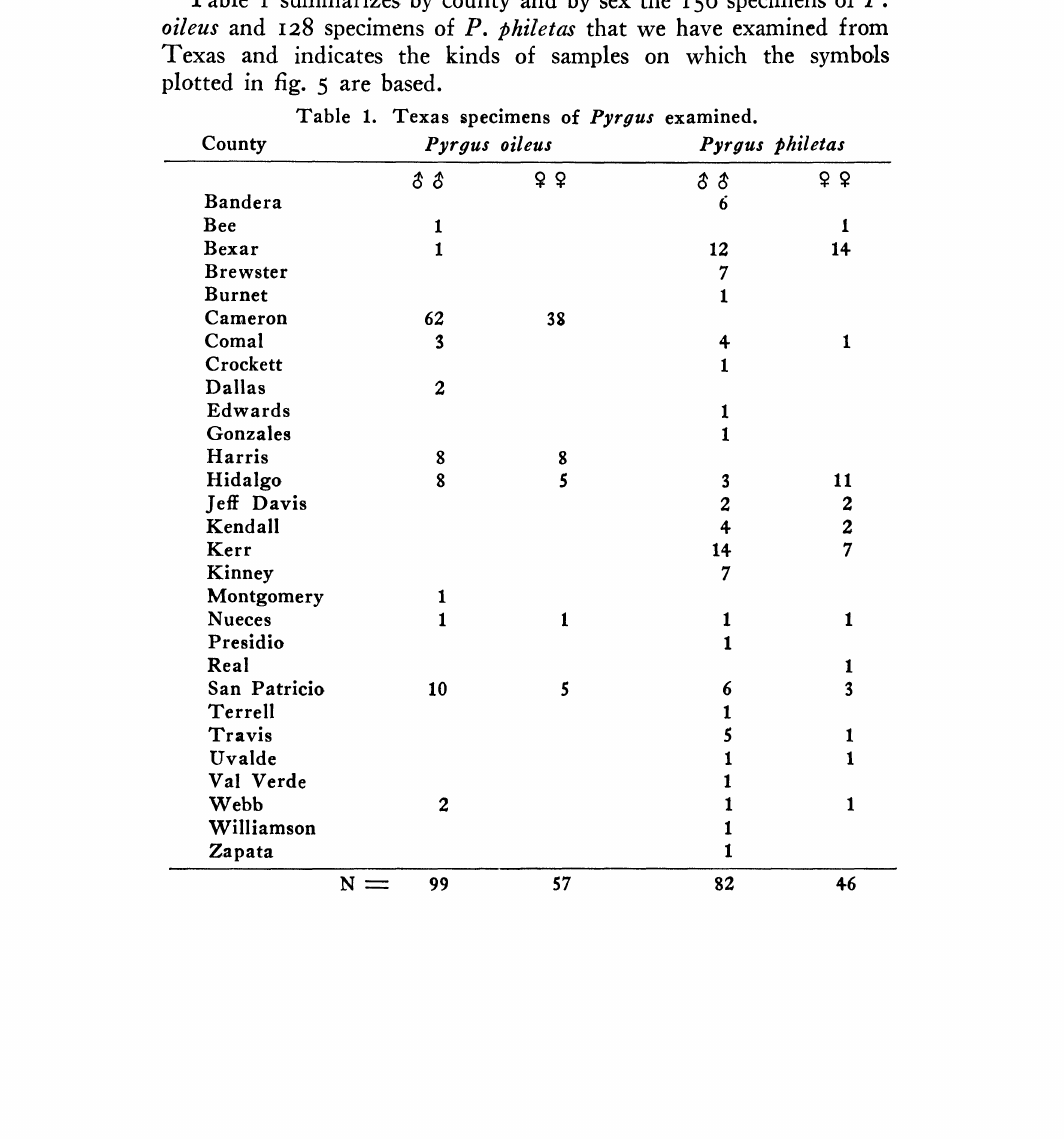
summarizes, by county and by sex the 56 specimens of P. oileus and 8 specimens o P. lhiletas that we have examined